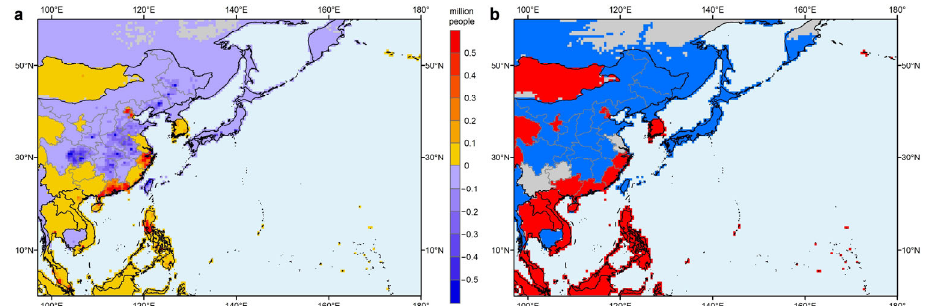
Figure 3. Spatial distribution of the population change in the Northwest Pacific. ( a ): Spatial distribution of the change in population over the period 2015–2050. ( b ): Regions with significant changes between periods are indicated in red (increased) and blue (decreased) at the 95% confidence level.